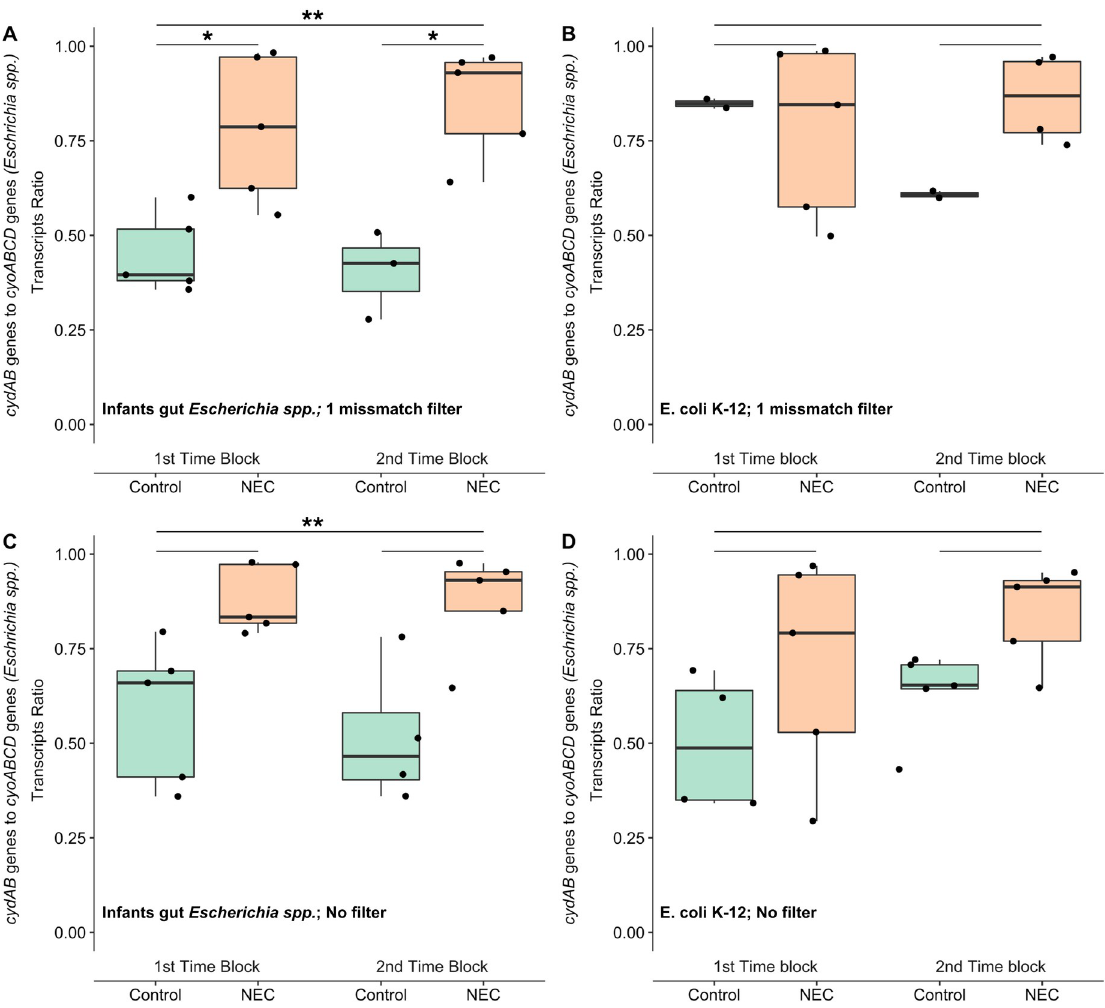
Fig 1. Transcriptional response to oxygen by Escherichia spp. in the gut of NEC and control premature infants. (A) Diametric ratios were compared between NEC and control infants in each time block (short lines above) and across all time points (longer lines). Distributions of diametric ratios were compared using Welch’s t-test with Bonferroni correction. Asterisks and double asterisks ( � , �� ) represent p < 0.05 and p < 0.01, respectively. (B) Diametric ratios of cydAB and cyoABCD transcript abundances of RNA reads mapped to gene sequences of Escherichia spp. genomes found in infants’ gut. Filtering of reads with more than 1 miss matches was applied. (C) Diametric ratios of cydAB and cyoABCD transcript abundances of RNA reads mapped to gene sequences of E . coli (K-12 MG1655) downloaded from KEGG (Kyoto Encyclopedia of Genes and Genomes) database. Filtering of reads with more than 1 miss matches was applied. (D) Diametric ratios of cydAB and cyoABCD transcript abundances of RNA reads mapped to gene sequences of Escherichia spp. genomes found in infants’ gut. No filtering of reads with miss matches was